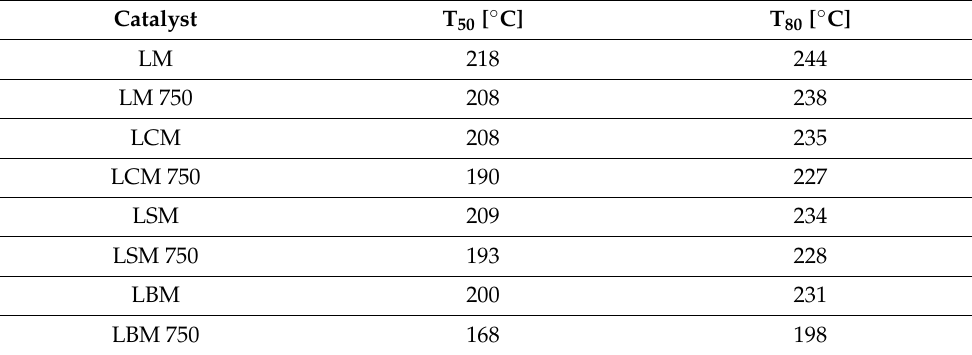
Table 1. Estimated temperature values ( ◦ C) for acetone conversions of 50 and 80% for the as-prepared and calcined